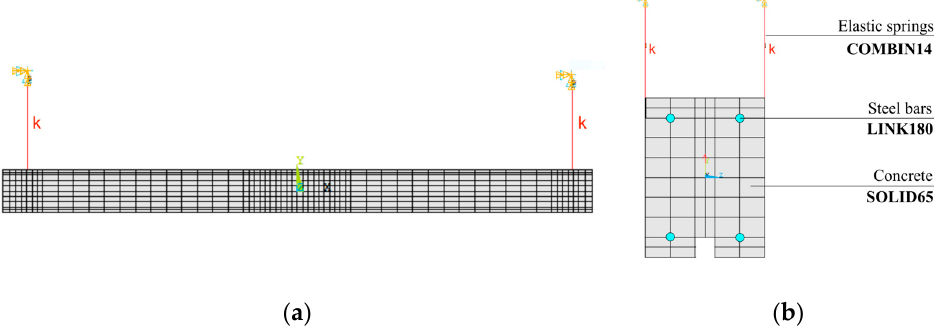
Figure 9. Typical mesh for FE analysis of RC beam with free–free ends: ( a ) front view; ( b ) cross-